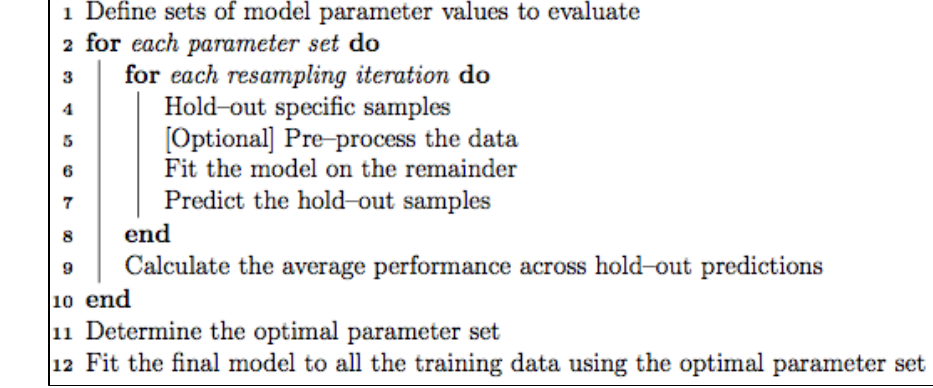
Figure 1. CARET package